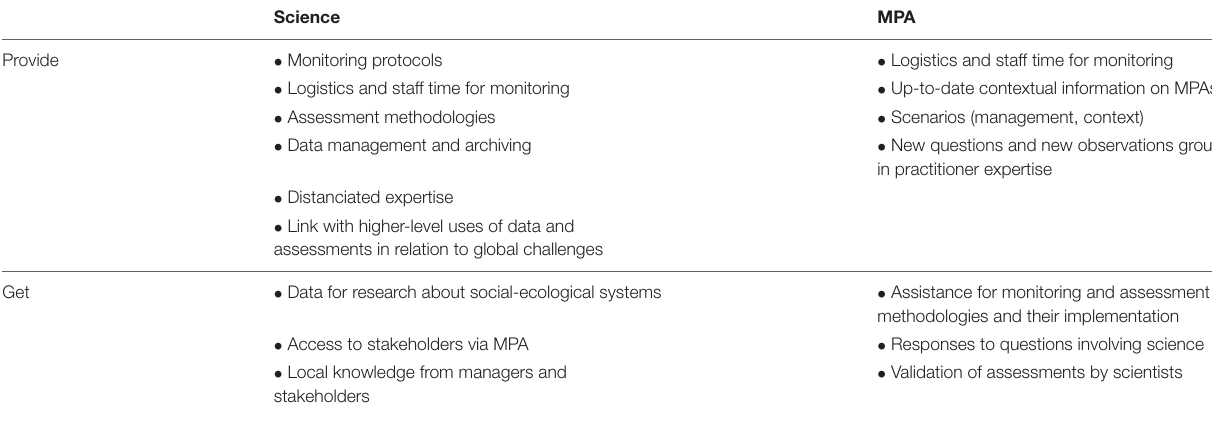
TABLE 3 | Synergies between coastal MPAs and transdisciplinary research into